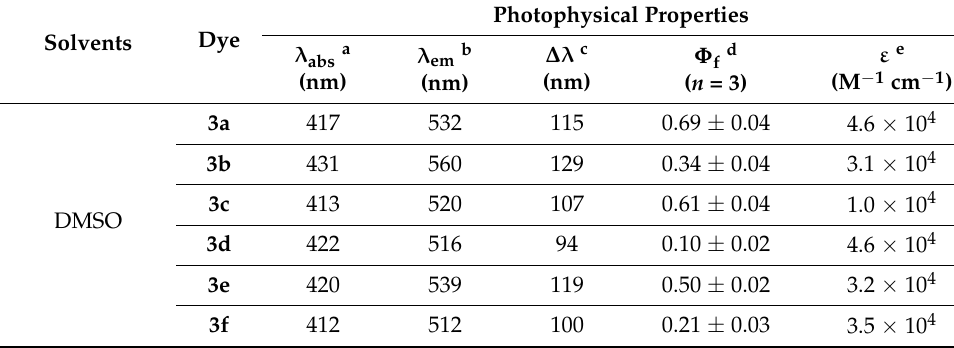
Table 1. Photophysical properties of chalcone 3a – f (2 µ M) in different solvents.